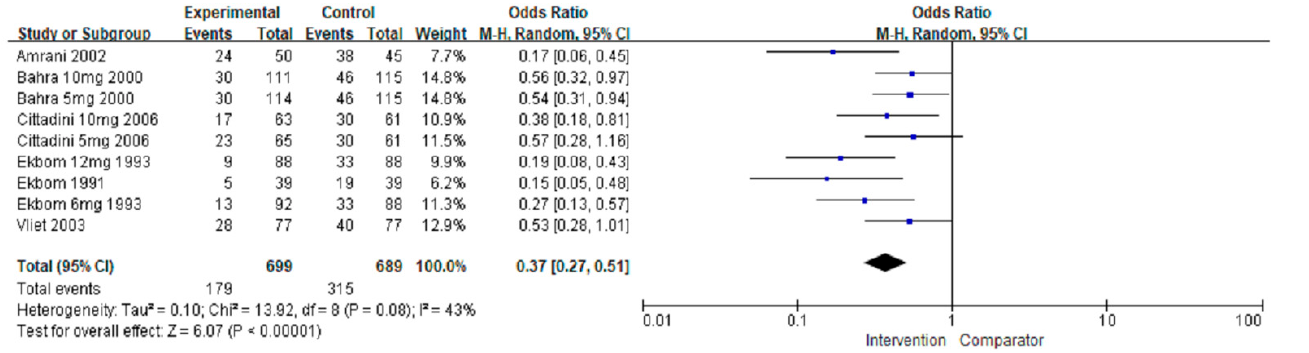
Figure 7. The overall effect of pharmacological treatment for the number of patients using rescue agents compared to placebo. Blue squares indicated effect size for each of included studies and the size of blue square indicates the weight assigned to that study in the meta-analysis. Black diamond suggested as meta-analyzed measure of effect. Bold letters represented a category or subtotal of overall outcome.